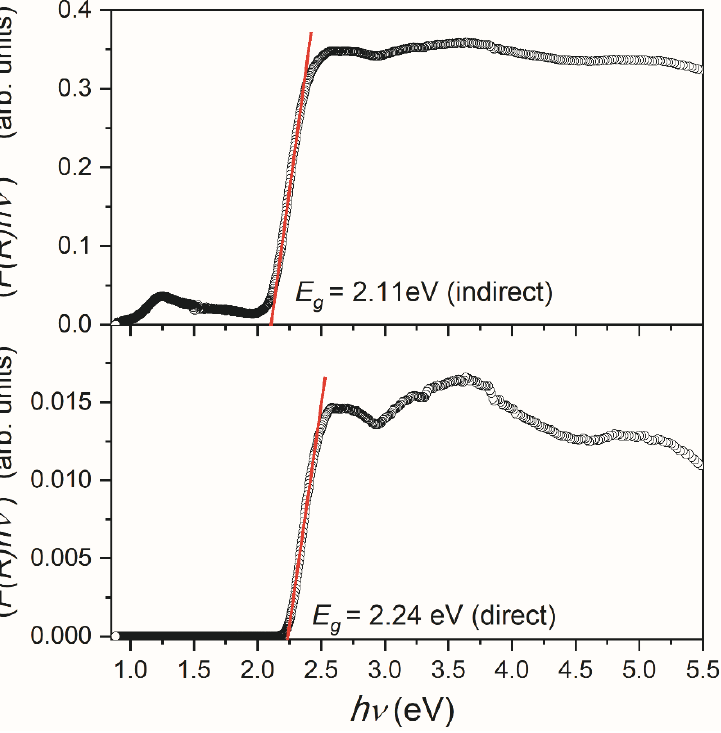
Figure 6. Transformed Kubelka–Munk functions ( F ( R ) h ν ) 2 and ( F ( R ) h ν ) 1/2 assuming direct and indirect energy bandgap in the V 2 O 5 sample, respectively.